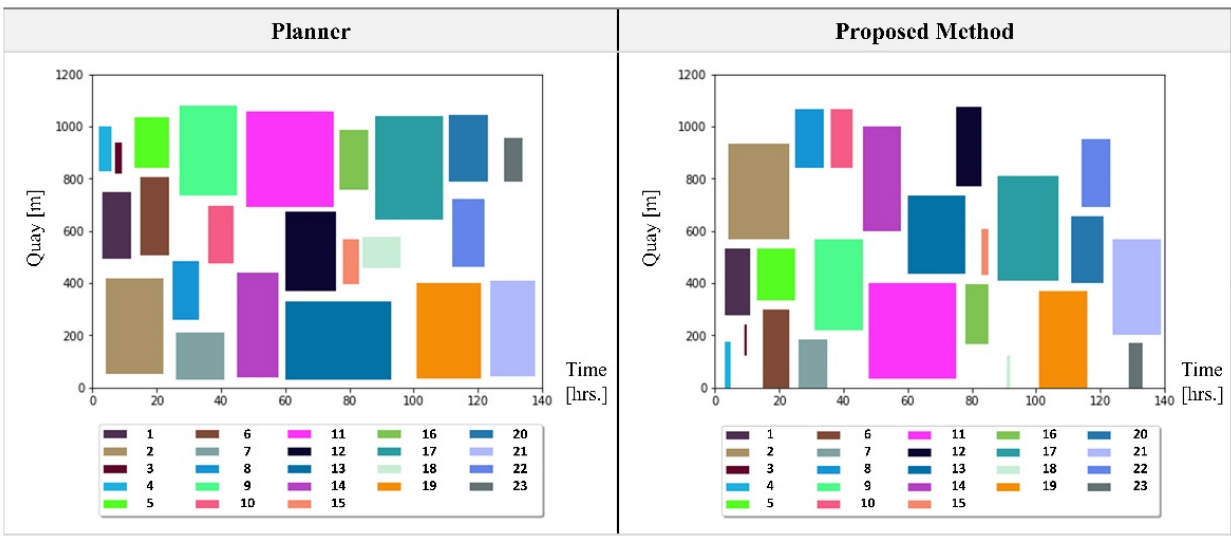
Figure 9. The result of Scenario 3.